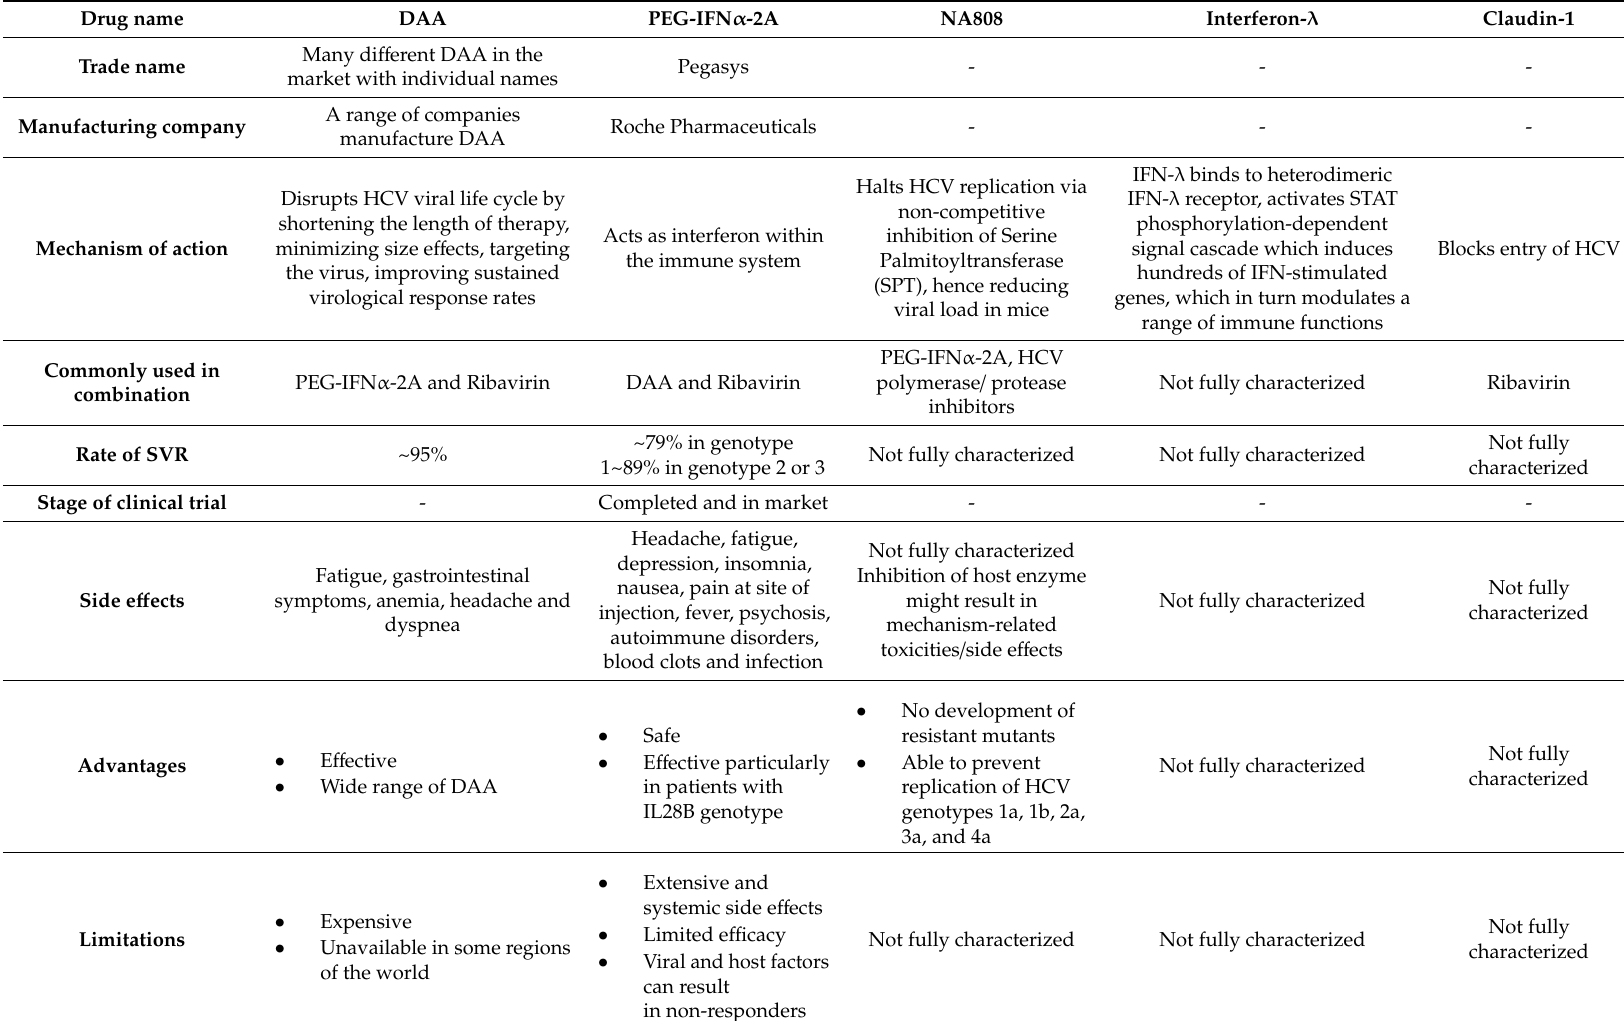
Table 5. Antiviral treatments for